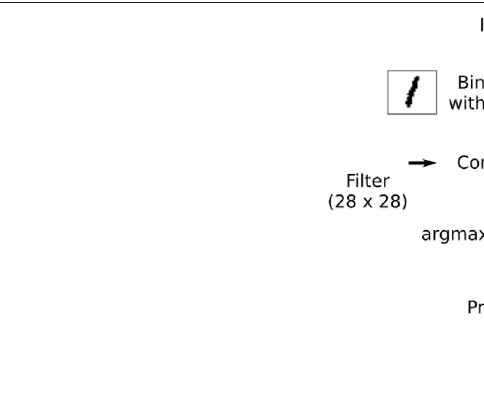
FIGURE 7 | The test setup for approximating convolution operations with logical